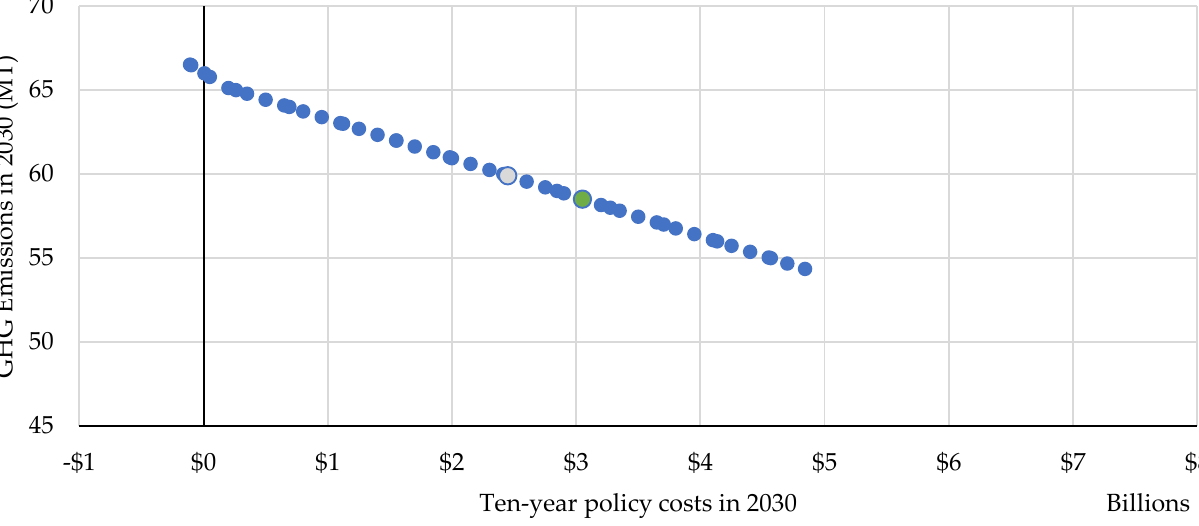
Figure A4. Pareto front 4 calculated from the MIO model. Assumes LDV fleet is 25% EV in 2030 (low-EV) and lower-bound TCO (low-TCO). Green and grey points represent the two policy scenarios (~3$ billion ten-year policy costs in 2030 and 40% GHG reduction relative to 2005 levels in year 2030) presented in Section 4.